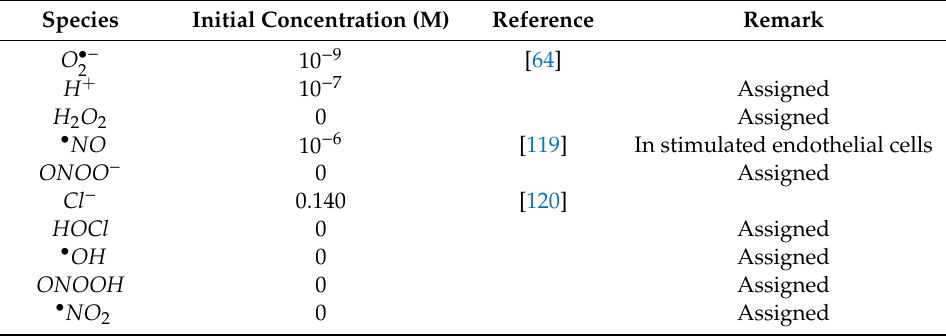
Table 3. Initial concentrations of the ROS and